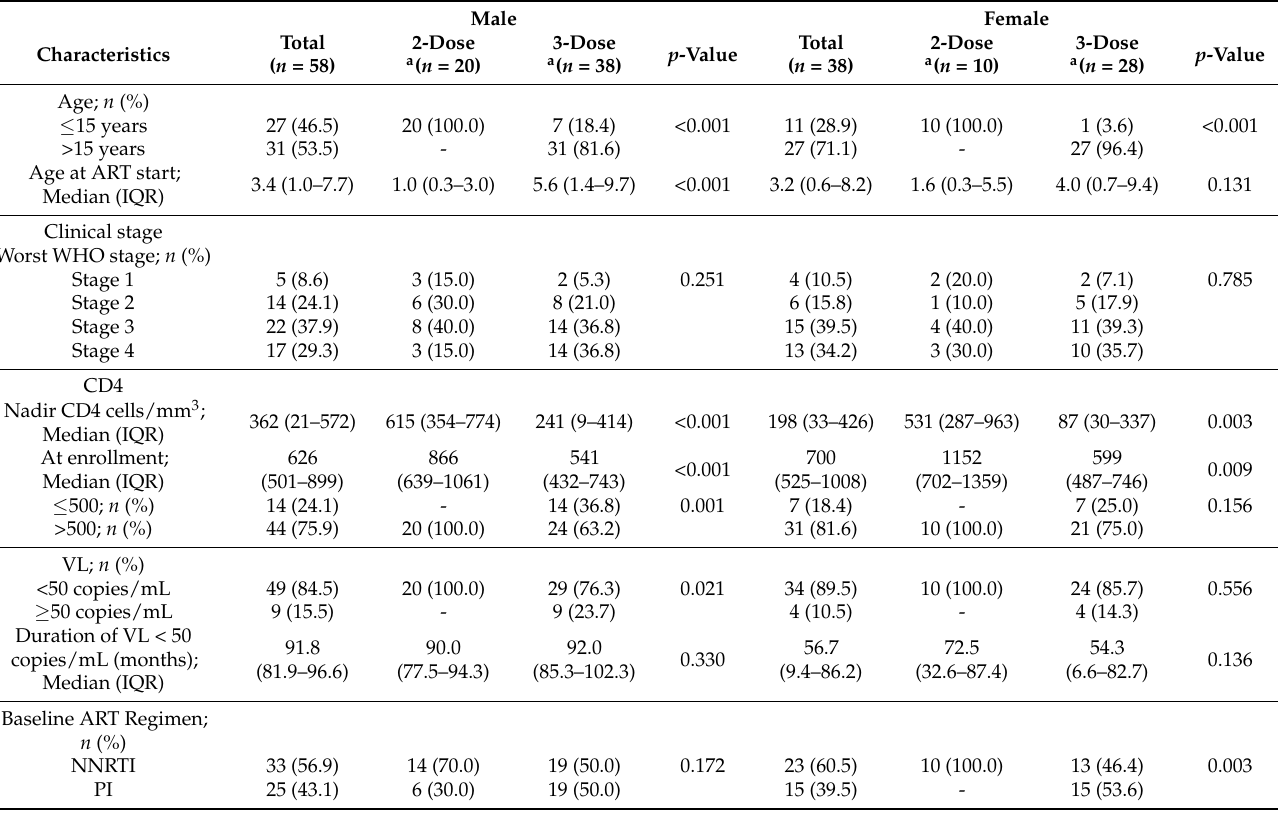
Table 1. Demographic characteristics of participants by vaccination schedule.